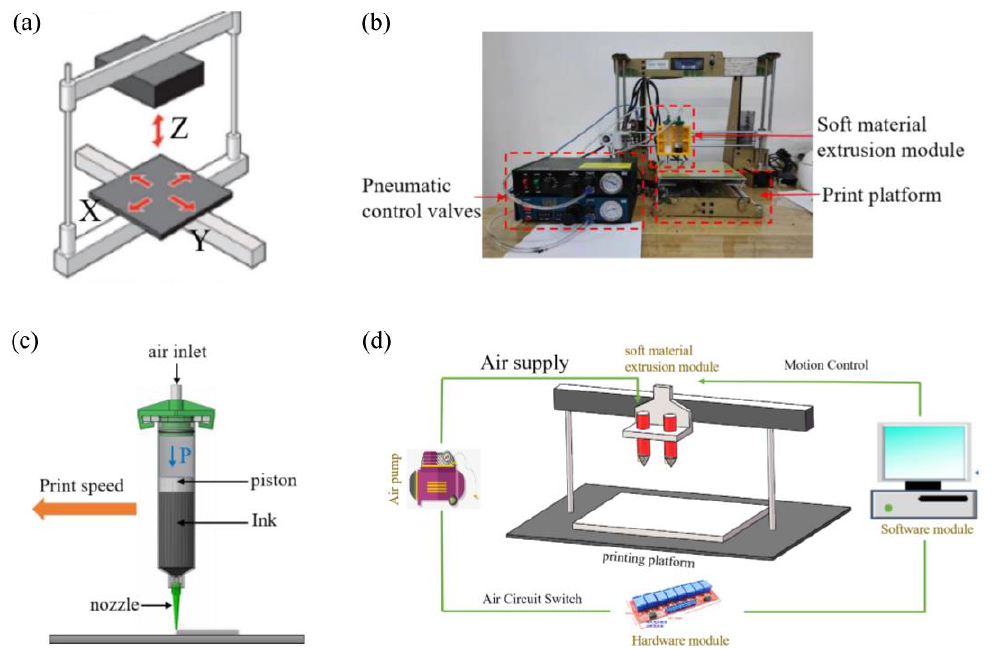
Figure 2. ( a ) Gantry type printing platform; ( b – d ) DIW and component modules.